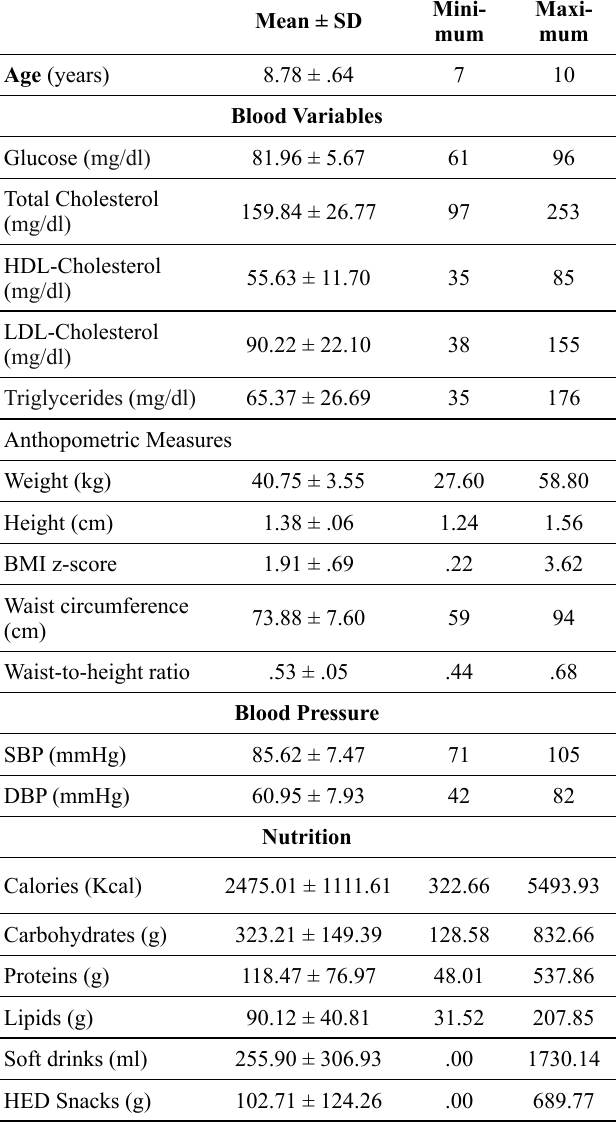
Table I. Descriptive characteristics of the study